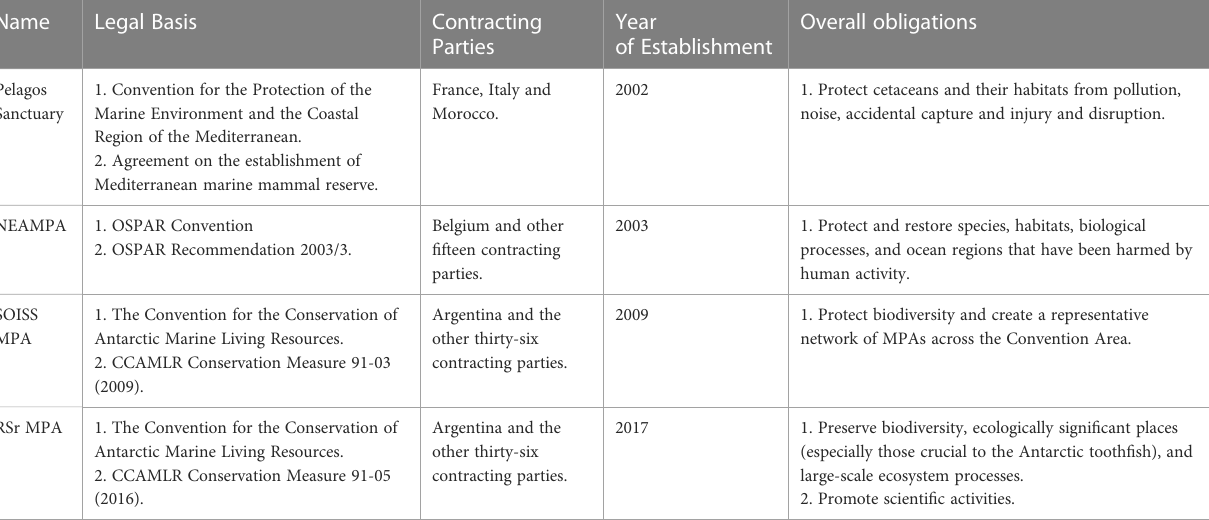
TABLE 1 Basic information of the four high seas MPAs.